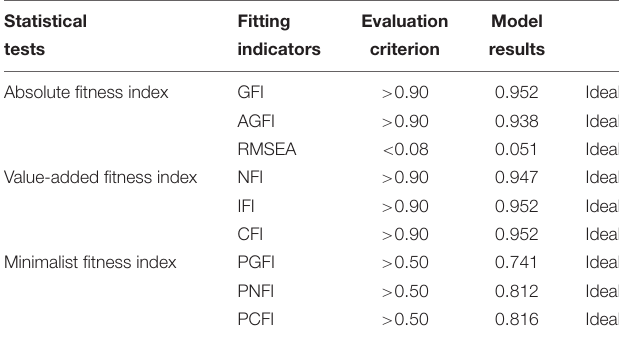
TABLE 4 | Model fitting index values.